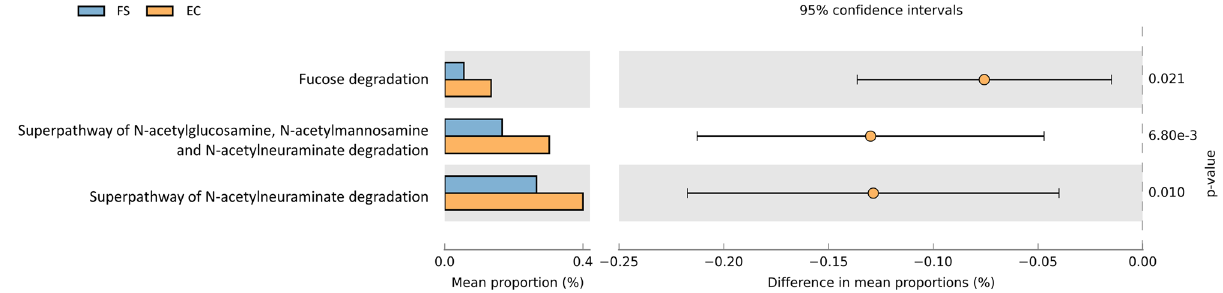
Figure 4. Pathways related to mucin degradation reconstructed from 16S rRNA profile with PICRUSt2 and presenting a significant (P < 0.05) differential abundance between FS and EC. The figure was created with STAMP v2.1.3, available at https:// beiko lab. cs. dal. ca/ softw are/